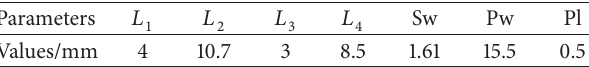
Figure 5: Simulated 𝑆 21 with one or two double-layered structures. Table 2: Dimensions of the proposed